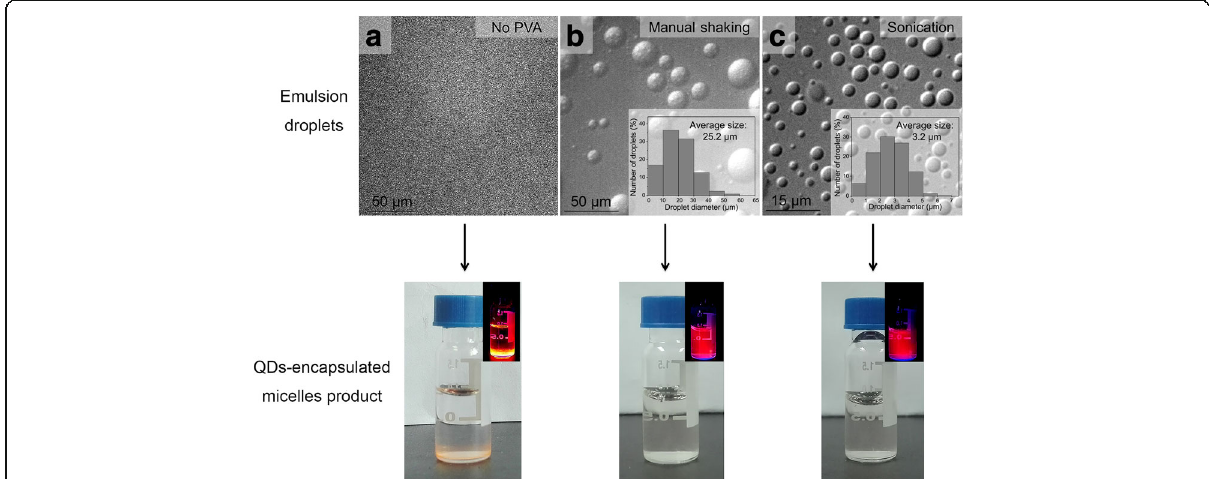
Fig. 1 Visual observation of the emulsion droplets and the resulted QD-encapsulated micelles after organic solvent evaporation. a No PVA was used. Few to no emulsion droplets were formed ( top image ); few to no QD-encapsulated micelles were formed upon organic solvent removal ( bottom image , the inset shows corresponding fluorescent image using a hand-held UV lamp to excite the red QD fluorescence). b Manual shaking was used to form emulsion droplets. ~25 μ m emulsion droplets were formed ( top image , the inset shows the droplet size measurement result from image analysis of 500 droplets). Additionally, the size variation due to different shaking times was found to be minimal (Fig. S1). Upon organic solvent removal a transparent and homogeneous dispersion was formed, indicating successful formation of nanocrystal-encapsulated micelles ( bottom image , the inset shows corresponding fluorescent image using a hand-held UV lamp to excite the red QD fluorescence). c Bath sonication was used to form emulsion droplets. ~3 μ m emulsion droplets were formed ( top image , the inset shows the droplet size measurement result from image analysis of 500 droplets). Additionally, the size variation due to different shaking times found to be minimal (Fig. S1). Upon organic solvent removal, a transparent and homogenous dispersion was formed, indicating successful formation of nanocrystal-encapsulated micelles ( bottom image , the inset shows corresponding fluorescent image using a hand-held UV lamp to excite the red QD fluorescence). To analyze the size of emulsion droplets of a particular sample, firstly, a light microscopy image of the emulsion droplets was taken, and subsequently, the diameters of ~500 droplets were measured by the free software ImageJ to obtain the average size and size distribution of the emulsion droplets of the